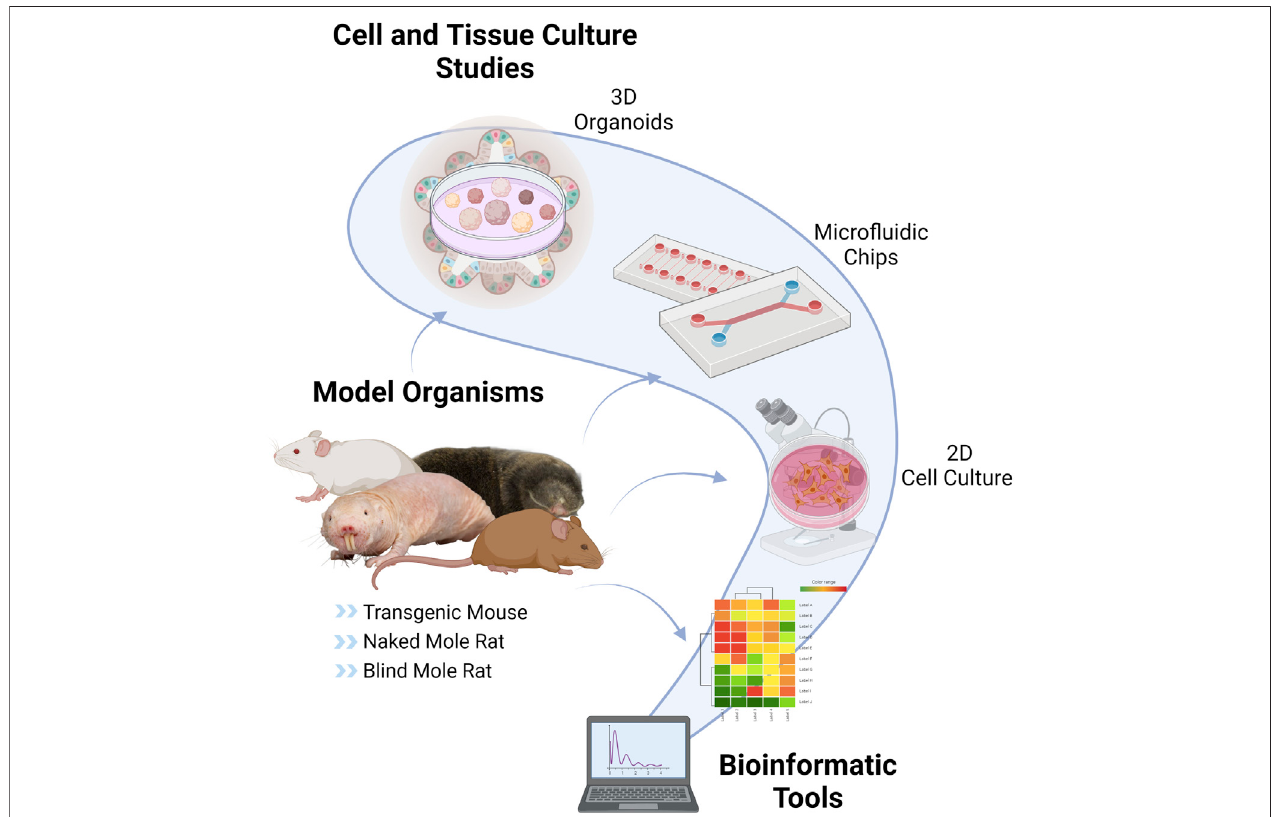
FIGURE 2 | Tools and Models of Cellular Senescence. CS can be studied by using various techniques such as in vitro cell cultures, nonhuman models such as usual rodent models (mouse, rat), transgenic mouse models (LMNA progeria mouse, p16-3MR mouse, Burb1 mouse, SAMP/SAMR mouse), special aging models (naked mole-rat, blind mole-rat), 3D organoids, micro fl uidic chips and bioinformatic applications This fi gure is created by BioRender.com.